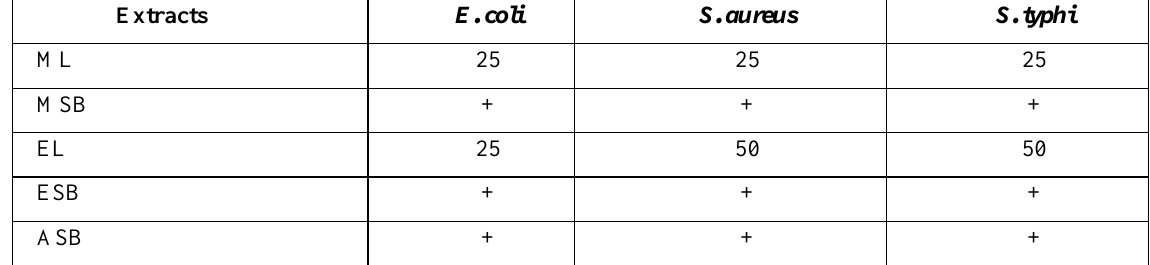
Table 4. Minimum inhibitory concentration (mic) of the extracts against the test organisms in mg/ml.